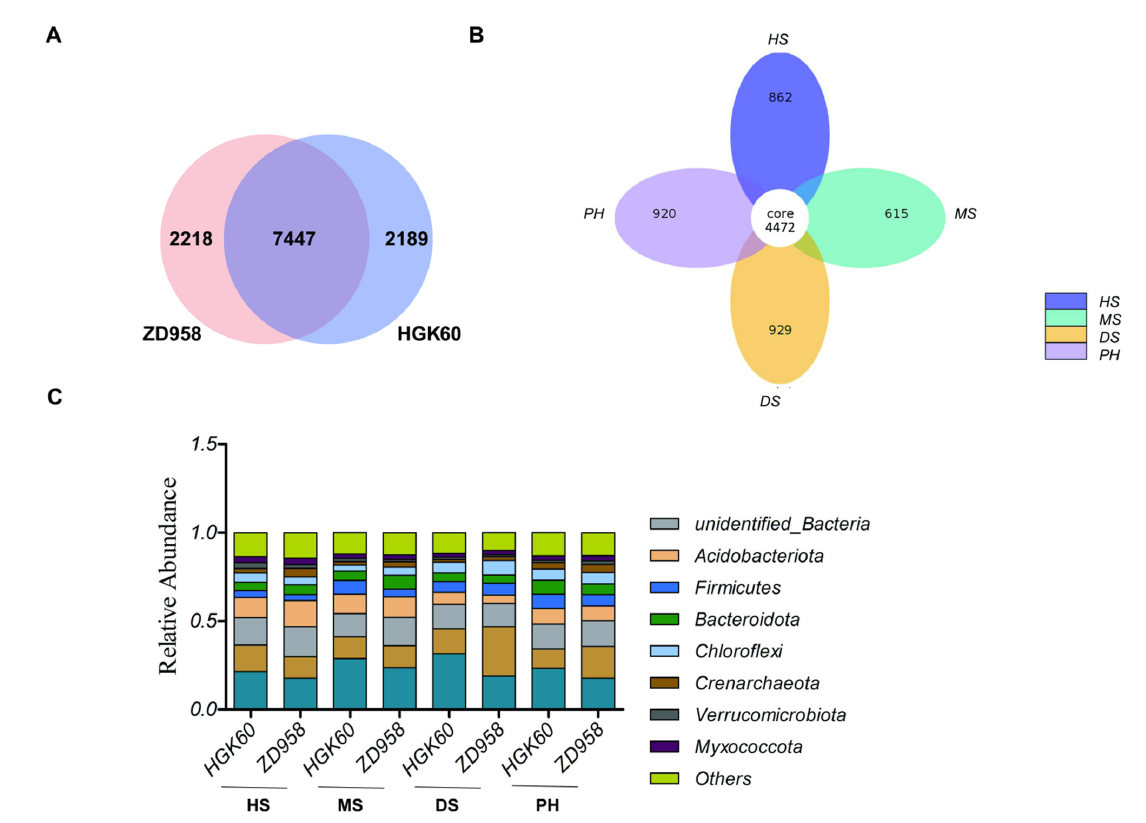
Figure 2. The composition of bacterial community in the rhizosphere soil of HGK60 and ZD958. ( A ) Venn diagram showing variable overlaps between HGK60 and ZD958; ( B ) Venn diagram showing variable overlaps between four growth stages; ( C ) relative read abundance of bacterial phyla within the communities. The numbers in ( A ) and ( B ) within the circles represent the operational taxonomic units (OTUs) numbers. HS—heading stage, MS—milk stage, DS—dough stage, and PH—post-harvest stage. Table 1. Diversity index of rhizosphere bacteria and fungi in different groups.